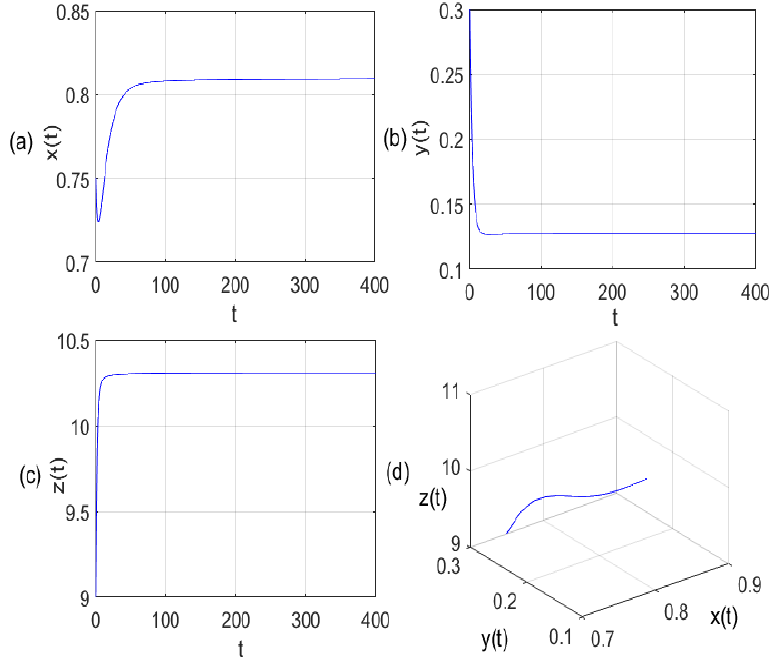
Figure 9. Evolution of the controlled system (18) with k 1 = 1, k 2 = 5, k 3 = 10. ( a ) x ( t )- t ; ( b ) y ( t )- t ;